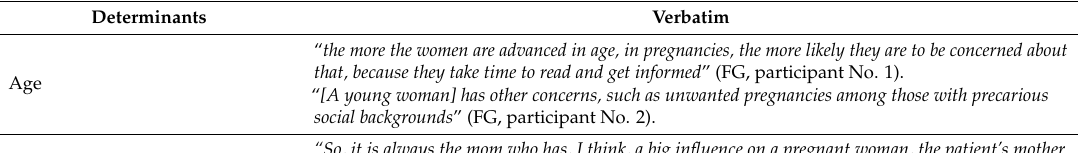
Table 3. Extracts of verbatim used to select determinants of EDC risk perception obtained from the qualitative